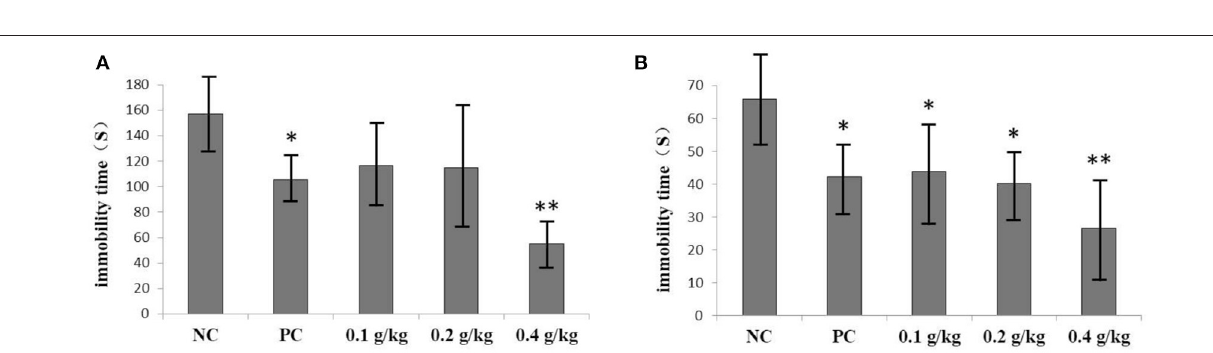
FIGURE 5 | Effects of Ganpu tea on the immobility duration of mice in the behavioral tests. (A) FST, and (B) TST. Data are expressed as mean ± SD ( n = 12 mice per group). NC, normal control group; PC, clomipramine hydrochloride tablets group (0.02 g/kg). The statistical analyses were performed using ANOVA, followed by LSD test, * p < 0.05, ** p < 0.01 as compared with that of the NC